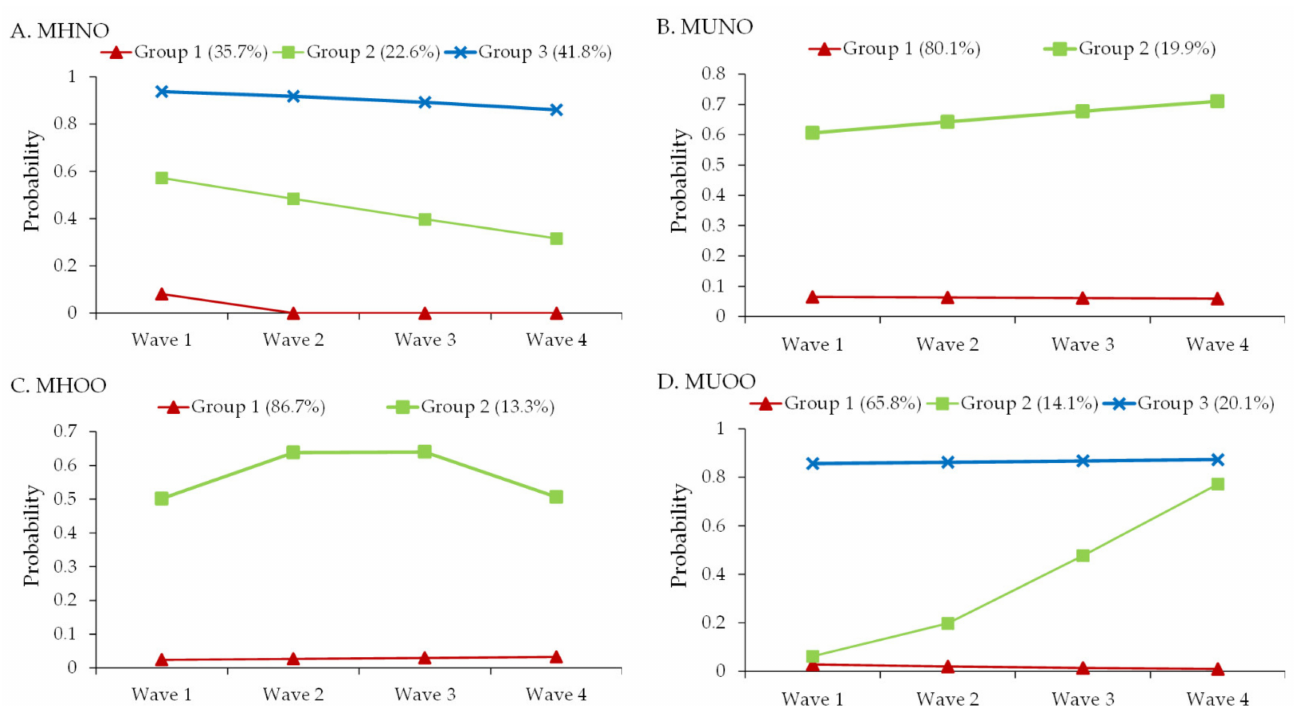
Figure 1. The best-fitting group-based trajectory models of ( A ) MHNO, ( B ) MUNO, ( C ) MHOO, and ( D ) MUOO. MHNO, metabolically healthy non-overweight; MUNO, metabolically unhealthy non- overweight; MHOO, metabolically healthy overweight/obesity; MUOO, metabolically unhealthy